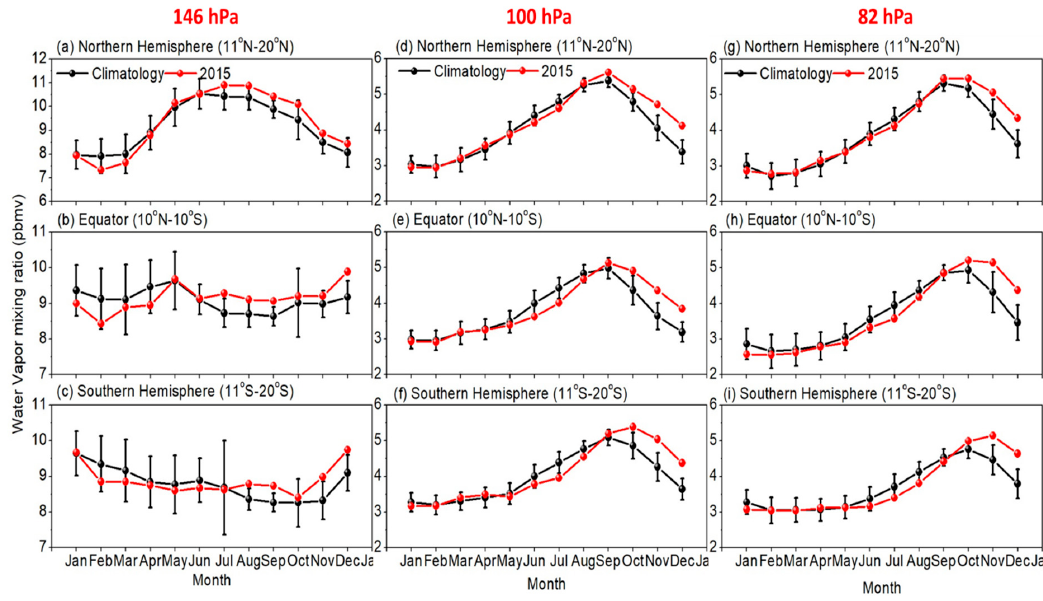
Figure 9. Same as Figure 2 but for the monthly mean of water vapor.